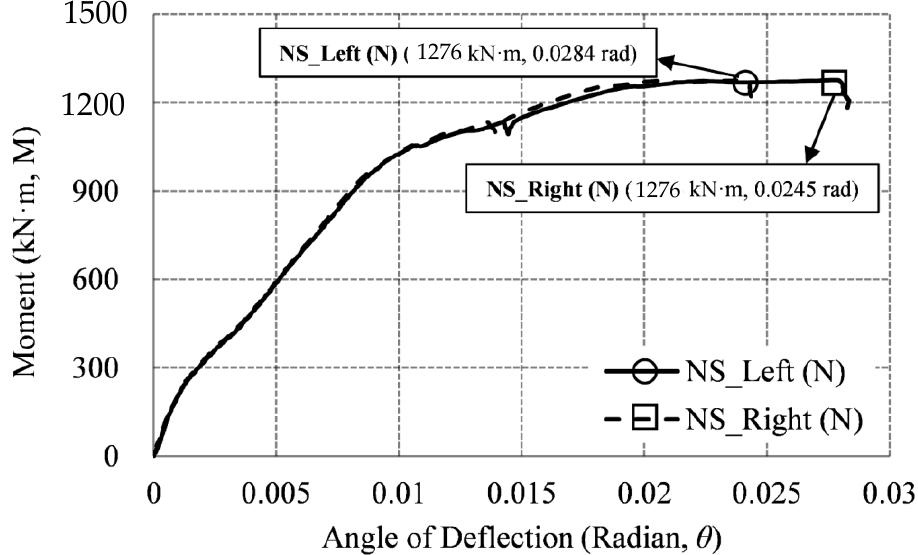
Figure 16. Moment – deflection angle relationship (NS specimen). Figure 16. Moment–deflection angle relationship (NS